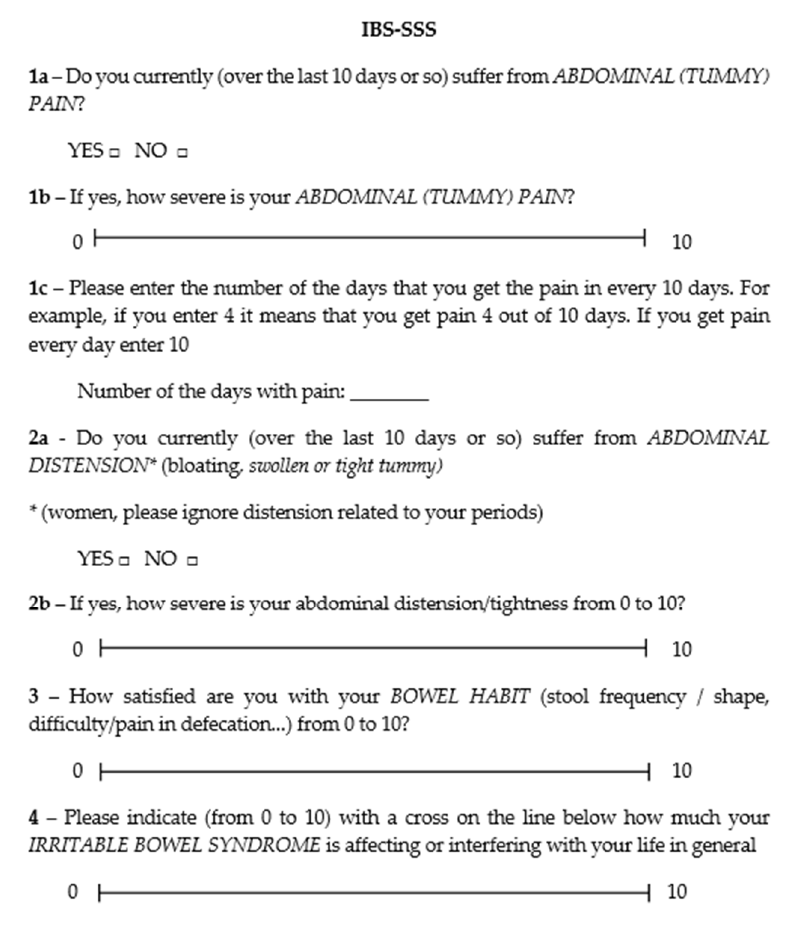
Figure A4. Figure A4. IBS-SSS.